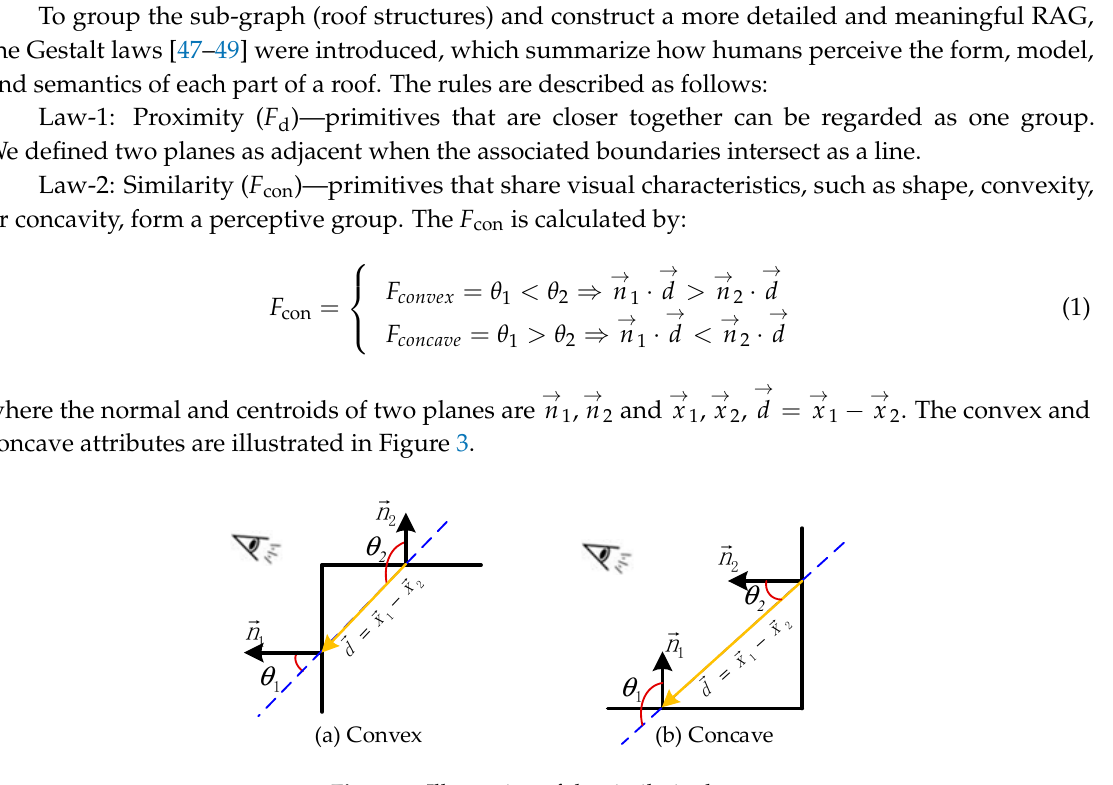
Figure 3. Illustration of the similarity law.